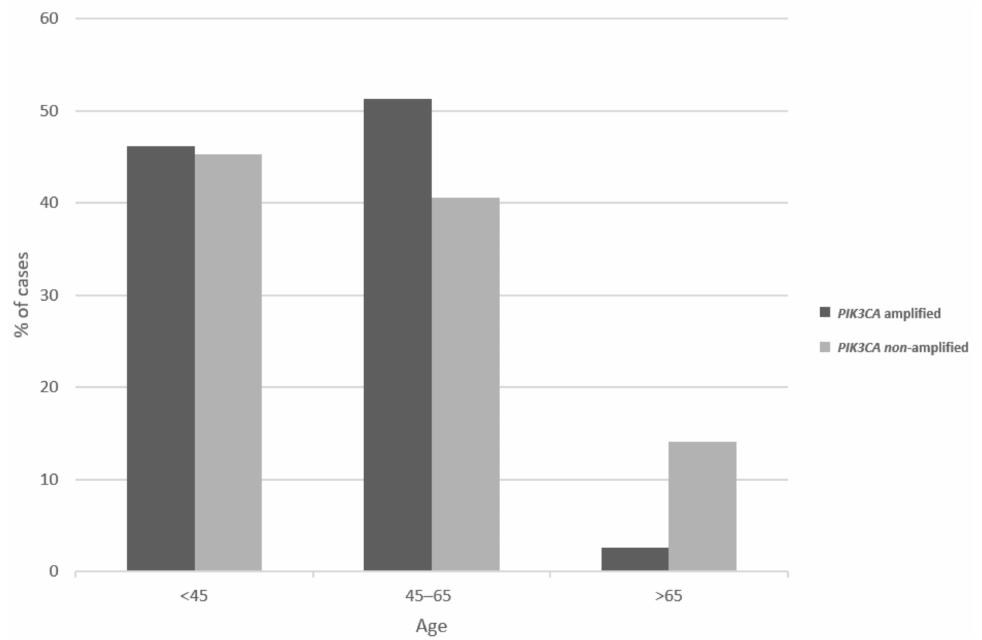
Figure 2. Distribution of age at presentation in squamous cervical carcinomas with and without 3q26 amplifications. Data are derived from the TCGA cervical cancer